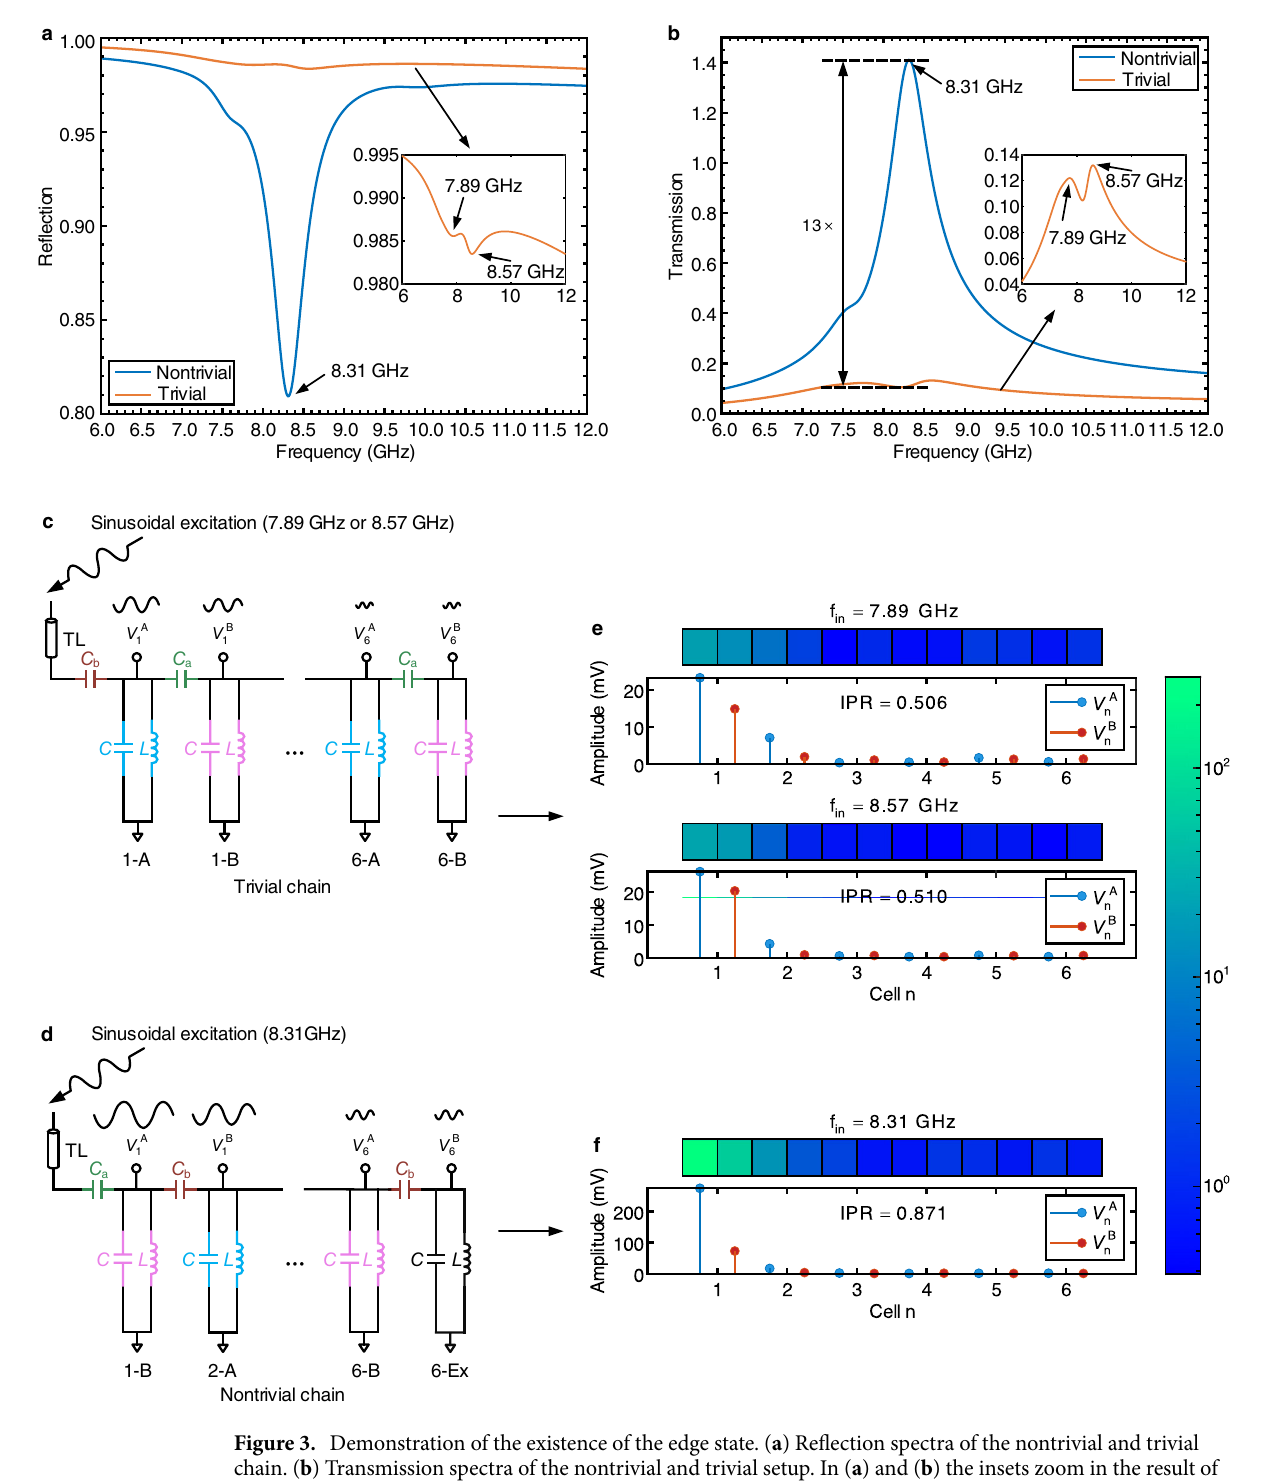
Figure 3. Demonstration of the existence of the edge state. ( a ) Reflection spectra of the nontrivial and trivial chain. ( b ) Transmission spectra of the nontrivial and trivial setup. In ( a ) and ( b ) the insets zoom in the result of the trivial setup. Arrows indicate the frequency location of the edge state and bulk state frequencies. ( c , d ) Trivial and nontrivial setup for the simulation of voltage profiles. ( e , f ) Voltage profiles of each sub-unit in the 1-D SSH circuit chain under a sinusoidal excitation with a 200 mV amplitude at two bulk state frequencies for the trivial setup and at the edge state frequency for the nontrivial setup. The color map inset shows the voltage amplitude across all sub-units in a log scale. Based on these voltage profiles, the IPR, a quantitative measurement of the degree of localization for each simulation is also calculated and labeled in each sub-figure. A larger IPR of the nontrivial chain shows a more localized